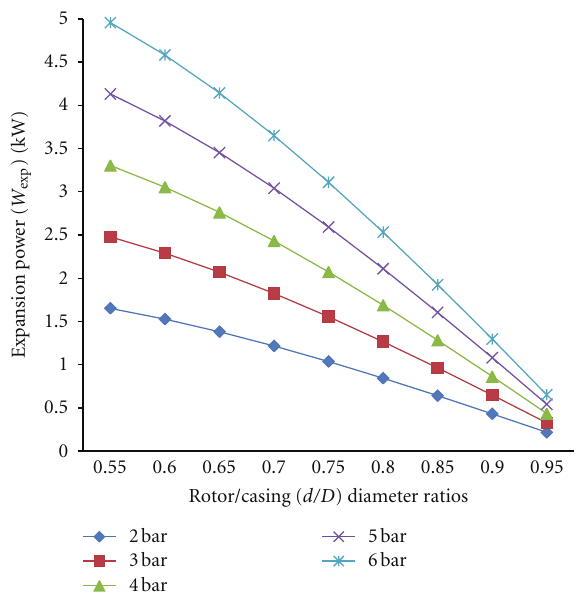
Figure 3: Expansion power versus rotor/casing diameter ( d/D ) ratio when D = 100 mm.